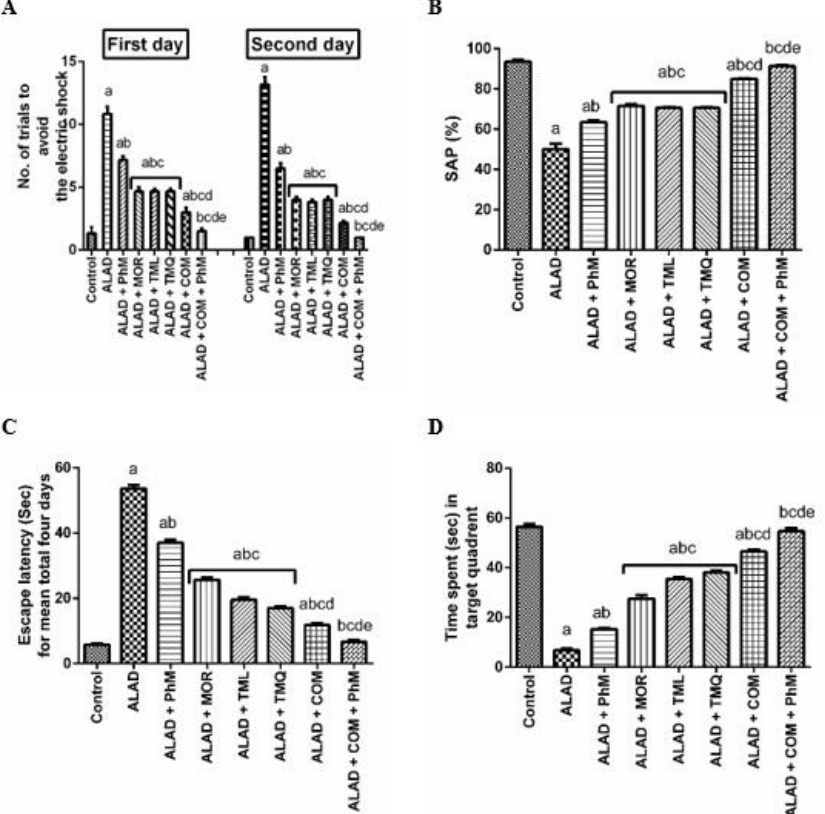
Figure 1. The effect of phytochemical combinations, MOR, TML, and TMQ, with PhM on the behavioral changes induced by AlCl 3 administration for five weeks (70 mg/kg/day, i.p.). ( A ) The number of trials to avoid the electric shock in CAR test. ( B ) SAP (%) in Y-Maze test. ( C ) The escape latency in four days. ( D ) The time spent in target the quadrant in the MWM test. The data are presented as means ± SD ( n = 10). Significance (a): relative to the control group. Significance (b): relative to the ALAD group. Significance (c): relative to ALAD + PhM group. Significance (d): relative to either ALAD + MOR, ALAD + TML, or ALAD + TMQ group. Significance (e): relative to ALAD + COM group. Significance: p < 0.05. The data of the effect of MOR, TML and TMQ on the control are not shown as they are not significant.